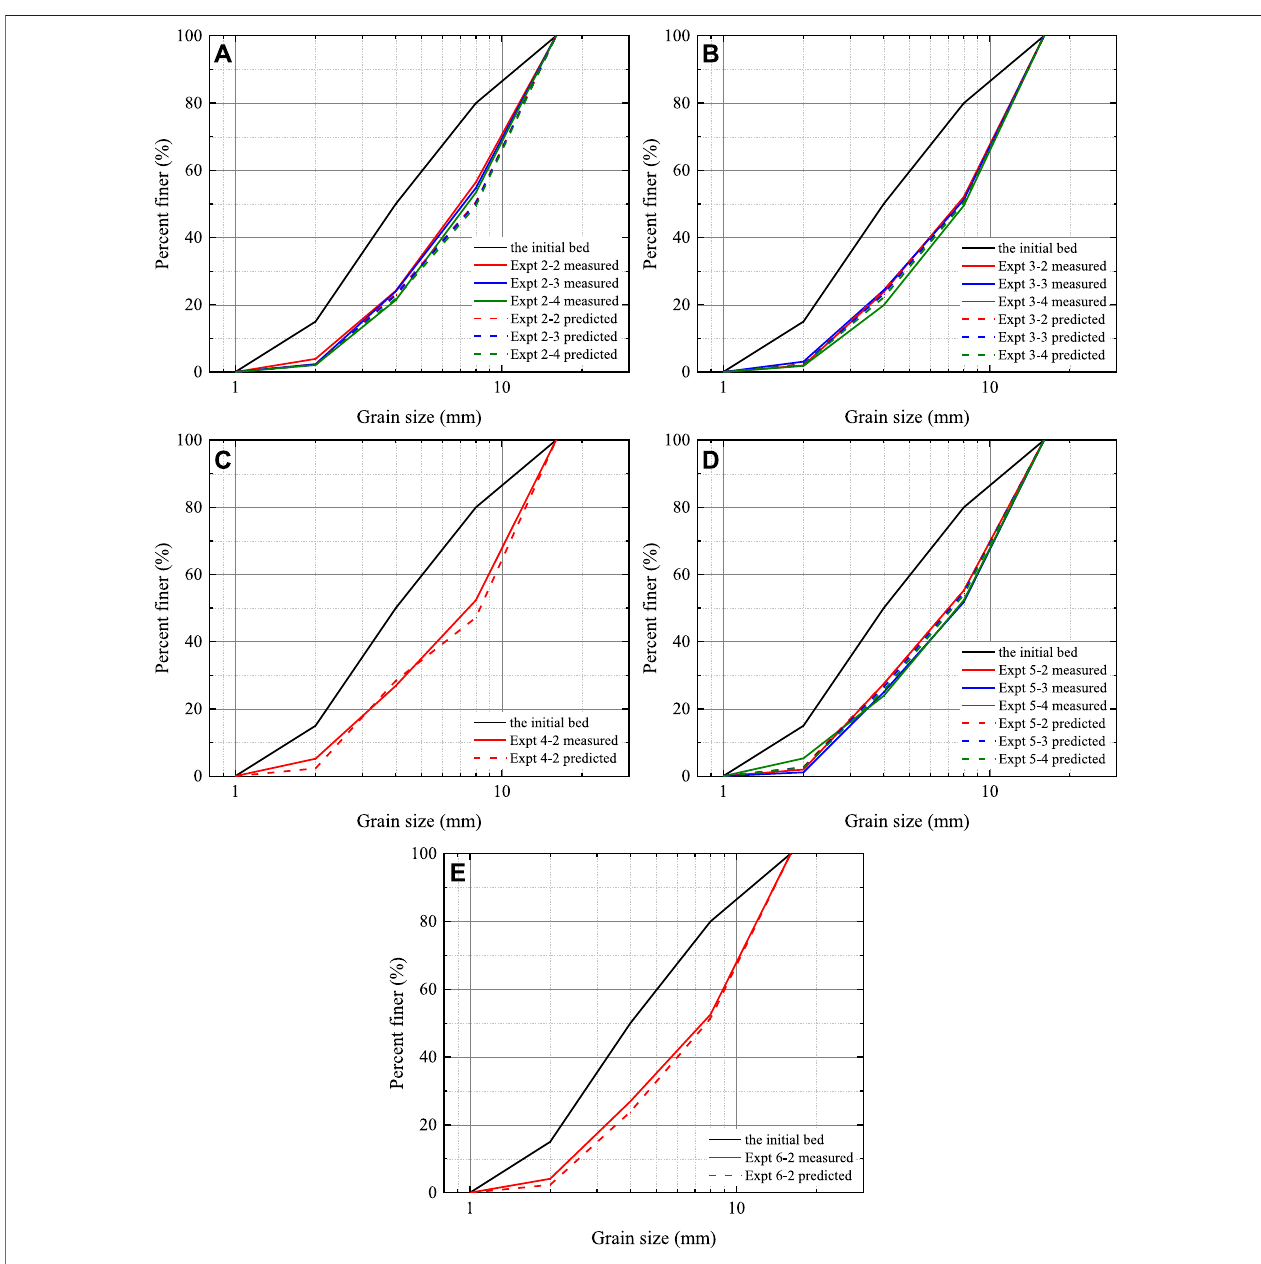
FIGURE6| Comparisonofmodelpredictedvaluesandactualmeasuredvaluesofdifferentexperiments (A) Expt.2, (B) Expt.3, (C) Expt.4, (D) Expt.5, (E) Expt.6